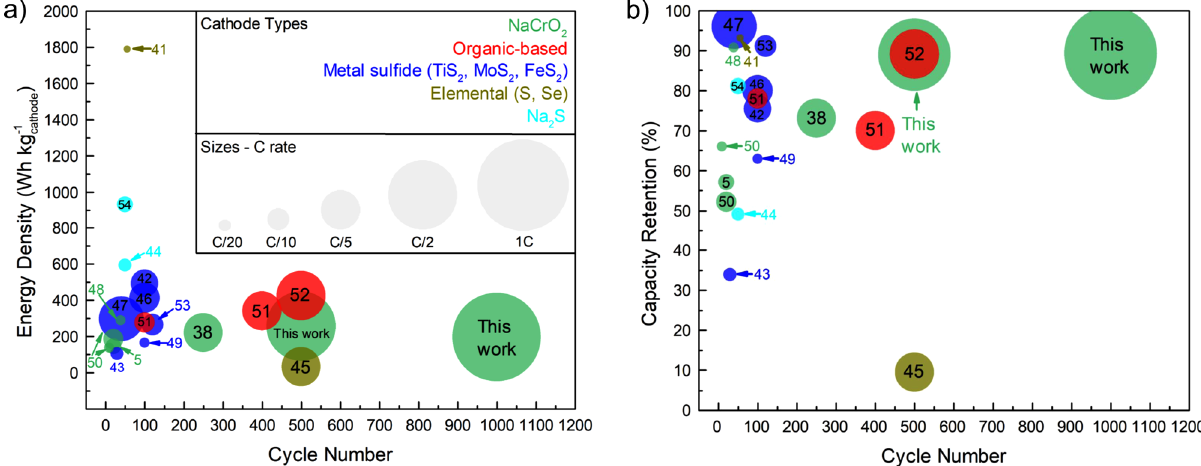
Fig. 6 Comparison of SSSB performance metrics. a Gravimetric energy density (per mass of active material) plotted as a function of cycle number. b Capacity retention as a function of cycle number 5,38,41 – 54 . The cycling performance comparison highlights the compatibility and stability of the NaCrO 2